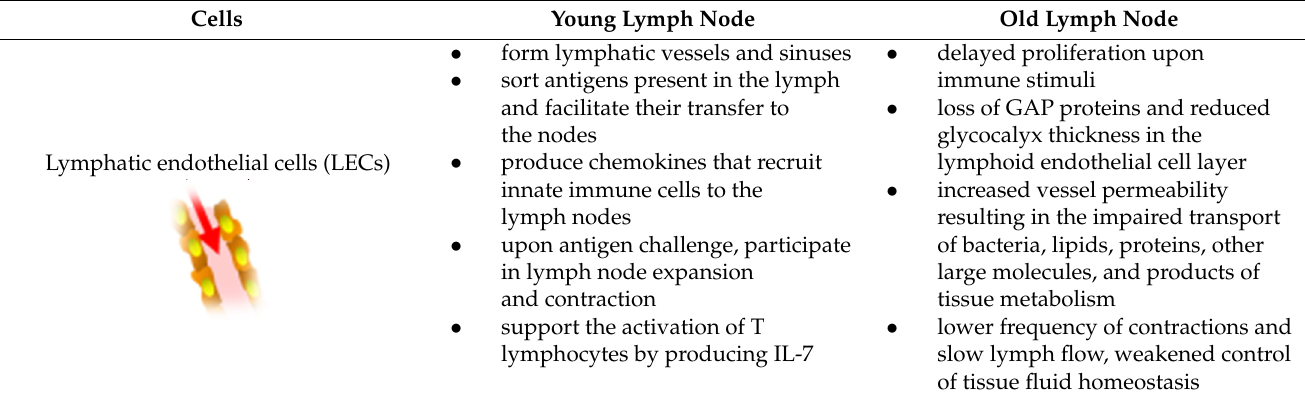
Table 1. Age-related changes in the structure and function of the lymph node stromal cells. Cells Young Lymph Node Old Lymph Node Lymphatic endothelial cells (LECs)